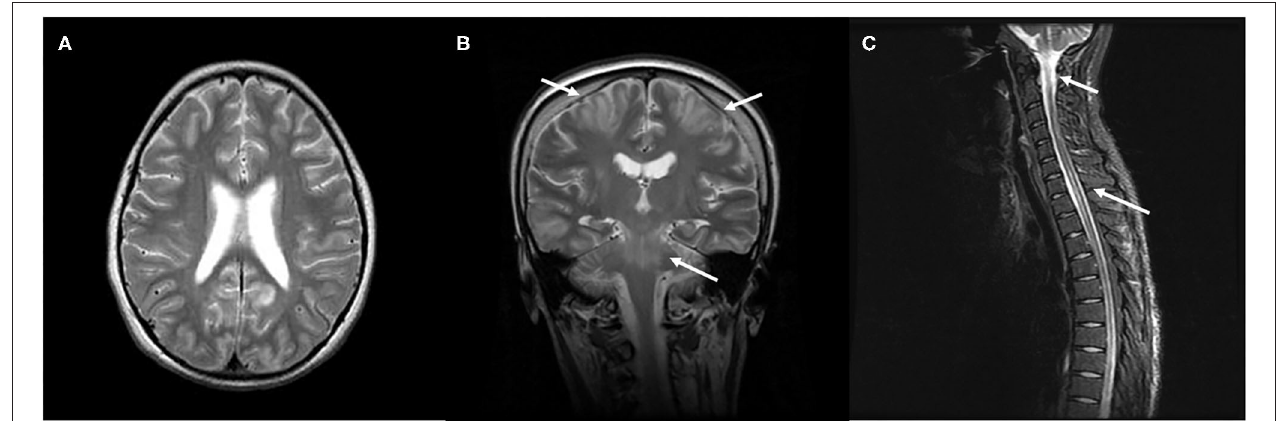
FIGURE 3 | Characteristic neuroimaging findings of a 15-year-old male with posterior reversible encephalopathy syndrome with spinal cord involvement (PRES-SCI). (A) Axial view of brain MRI showing T2-weighted hyperintensity in the bilateral parieto-occipital and frontal lobes. (B) Coronal view of MRI showing T2 hyperintensity in the brain stem, as well as in bilateral frontoparietal lobes (white arrows). (C) Sagittal cervicothoracic spine demonstrating longitudinally T2-weighted hyperintensity originating at cervicomedullary junction (white